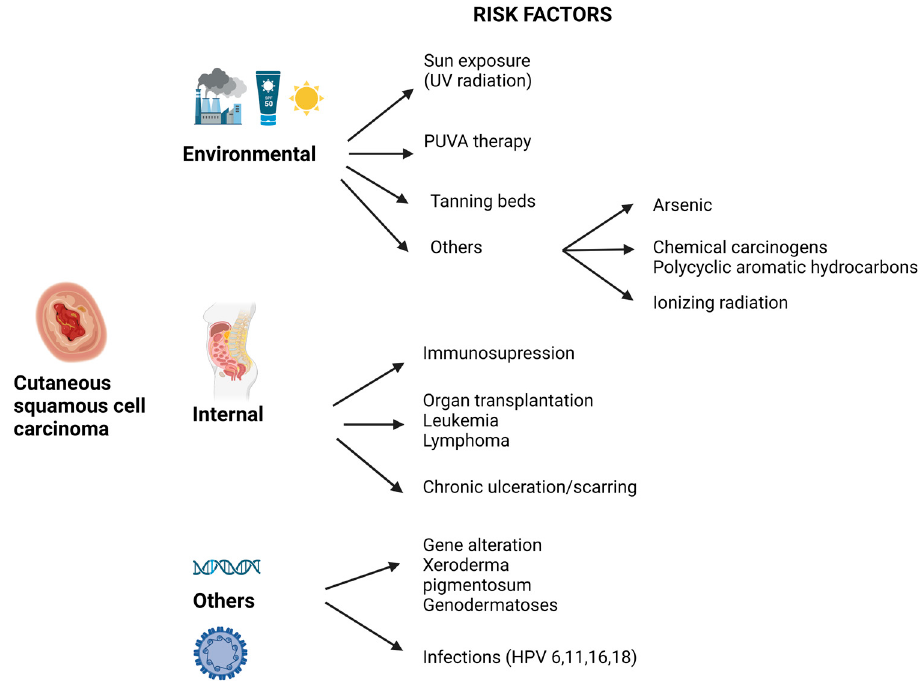
Figure 1. Risk factors for the development of cutaneous squamous cell carcinoma (This figure is created with BioRender.com, Agreement number NI24Y4NAV7) [3–5]